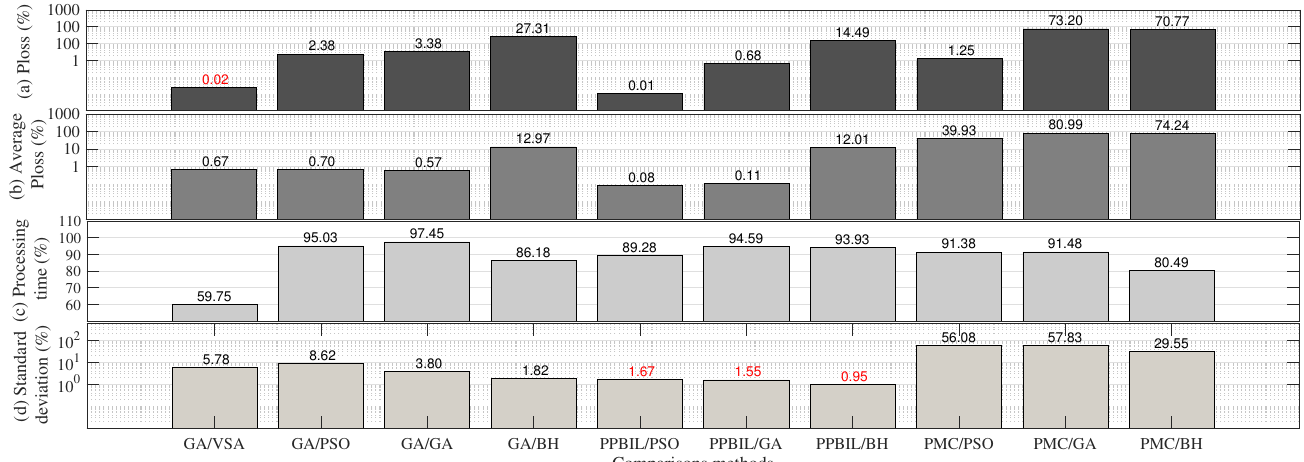
Figure 8. Reductions obtained by the PPBIL–VSA methodology with respect to the comparison methods in the 69-bus test